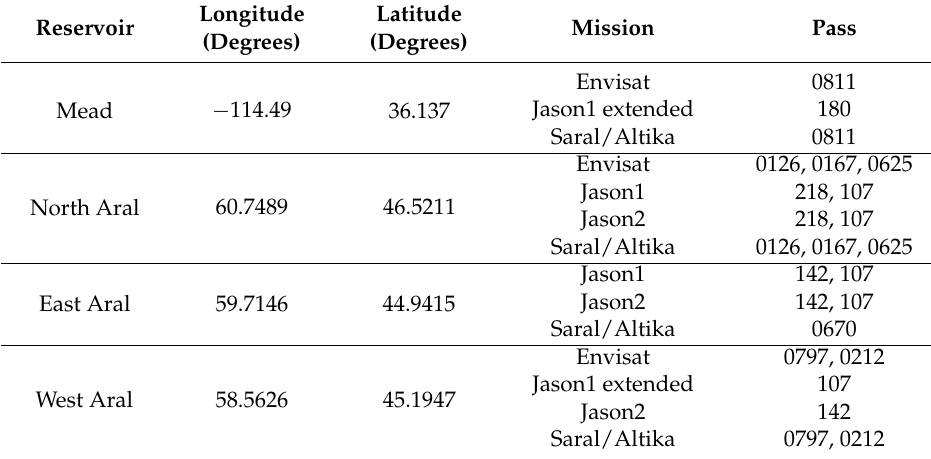
Table 1. Details of used altimetry